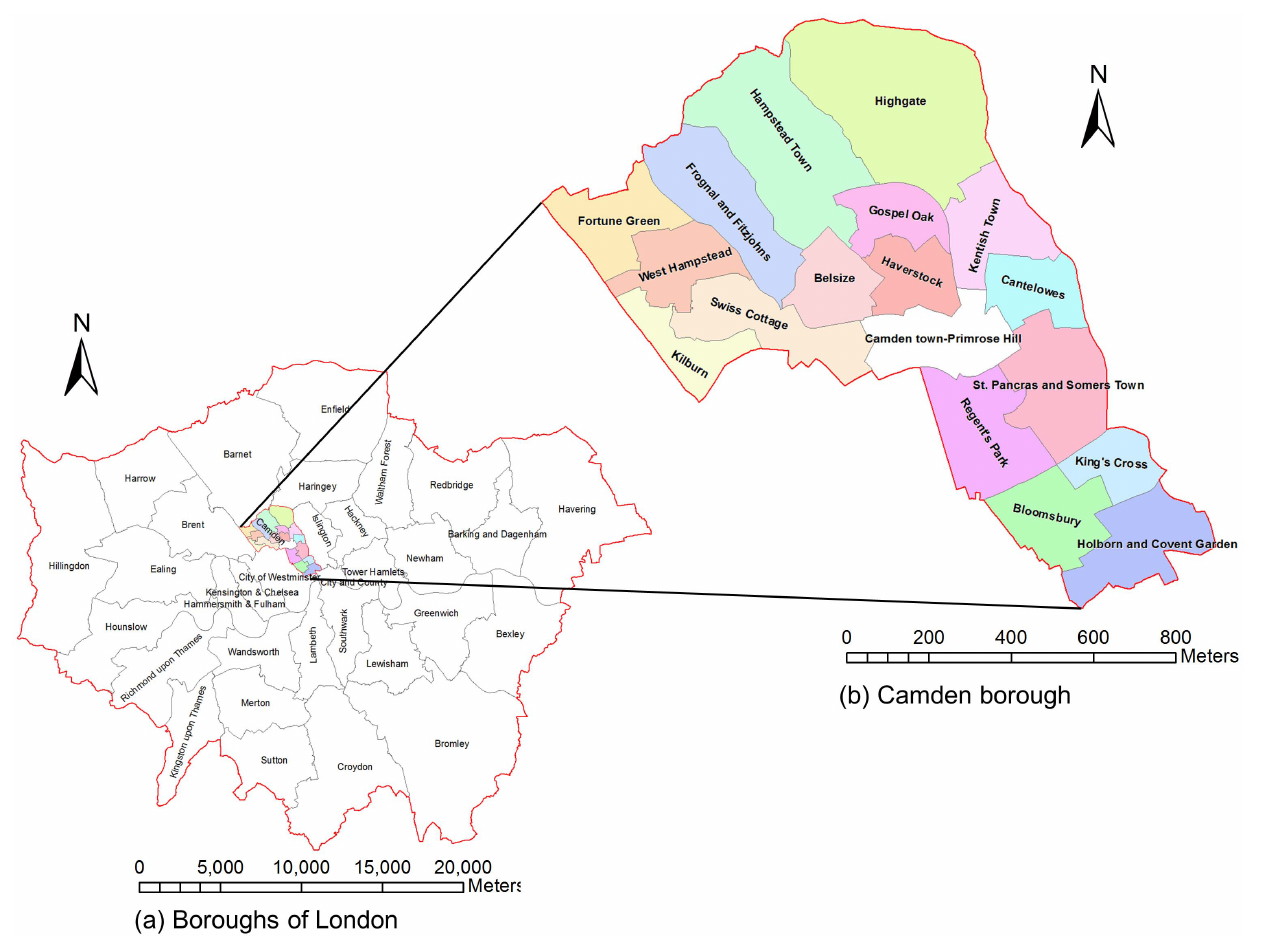
Figure 2. The study Area.